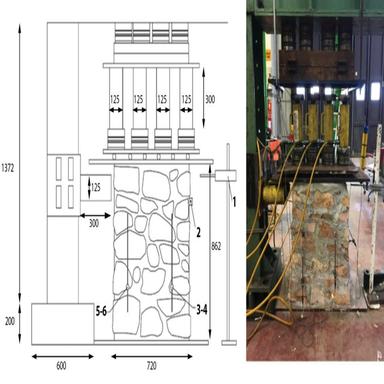
Load bearing - shear apparatus with matrix specimen (measures in mm).